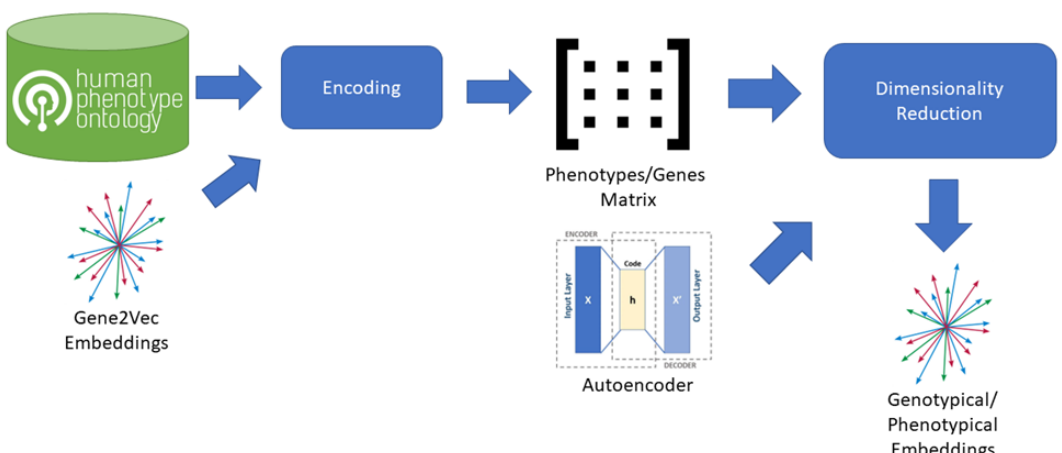
Figure 2. Process adopted to generate Genotypical/Phenotypical Embeddings from Gene2Vec. The process starts from a pre-existing embedding space for human genome that is Gene2Vec. Gene2Vec captures all the semantics of the interactions between genes, meaning that two genes are close in the embedding space if they have a mutual string interaction. For each phenotype in the HPO database the set of characterizing genes is extracted and encoded using Gene2Vec. The encoding transforms each gene into a 200-component vector. From the encoded phenotypes, a phenotypes/genes matrix is composed, having as many columns as the number of genes and as many rows as the number of phenotypes. Dimensionality reduction is applied using an autoencoder to reduce the initial 24,447 components to 64 components.